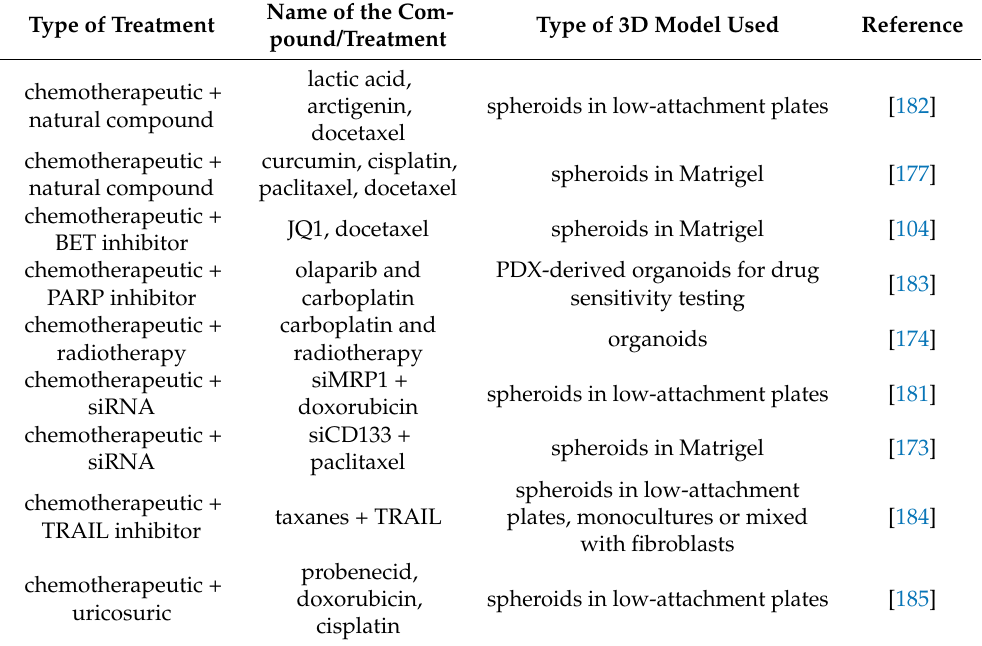
Table 2. Recent examples of the use of 3D in vitro models for testing of combinations of therapies. Name of the Type of Treatment